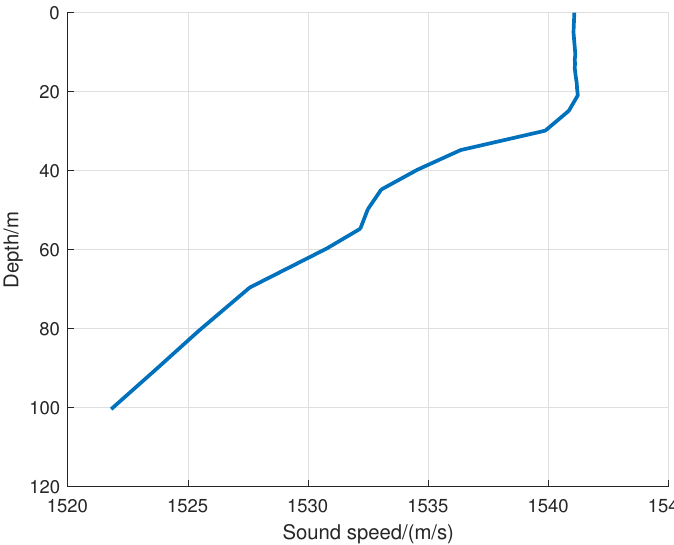
Figure 3. Sound speed profile.